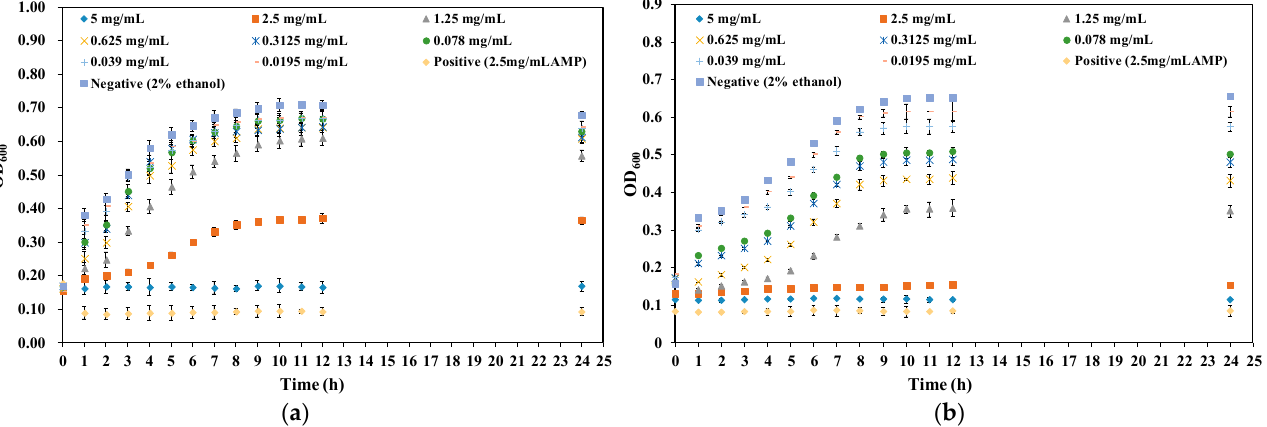
Y. enterocolitica .